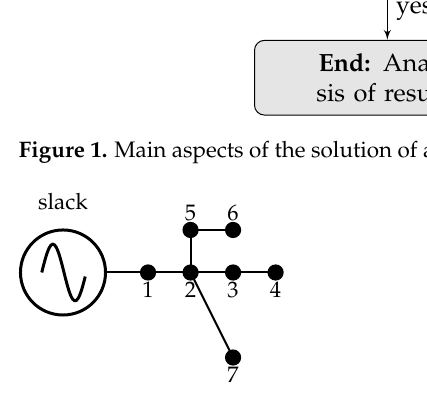
Figure 2. Schematic nodal connection of the 7-bus test feeder. Table 1. Branch and nodal parameters for the 7-bus